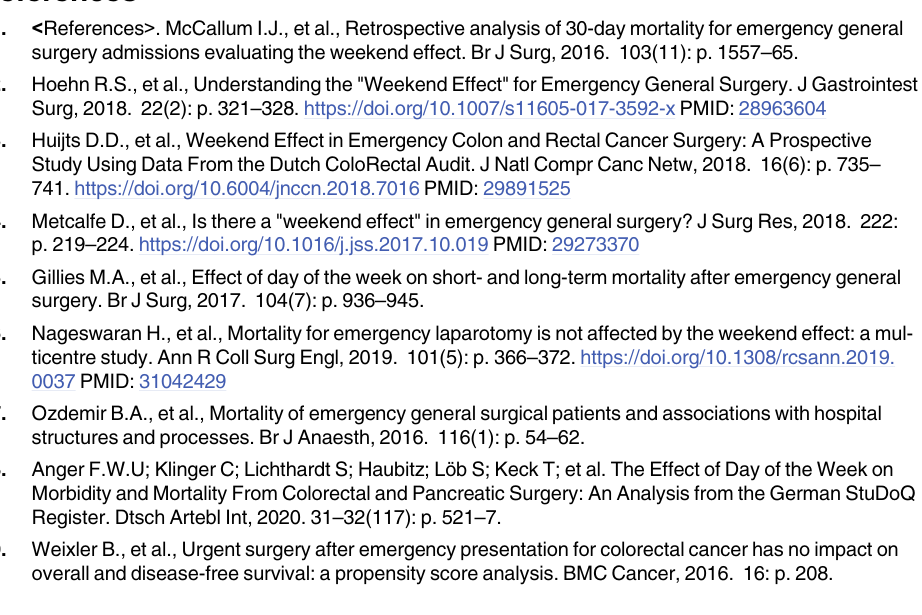
S1 Table. Basic patient